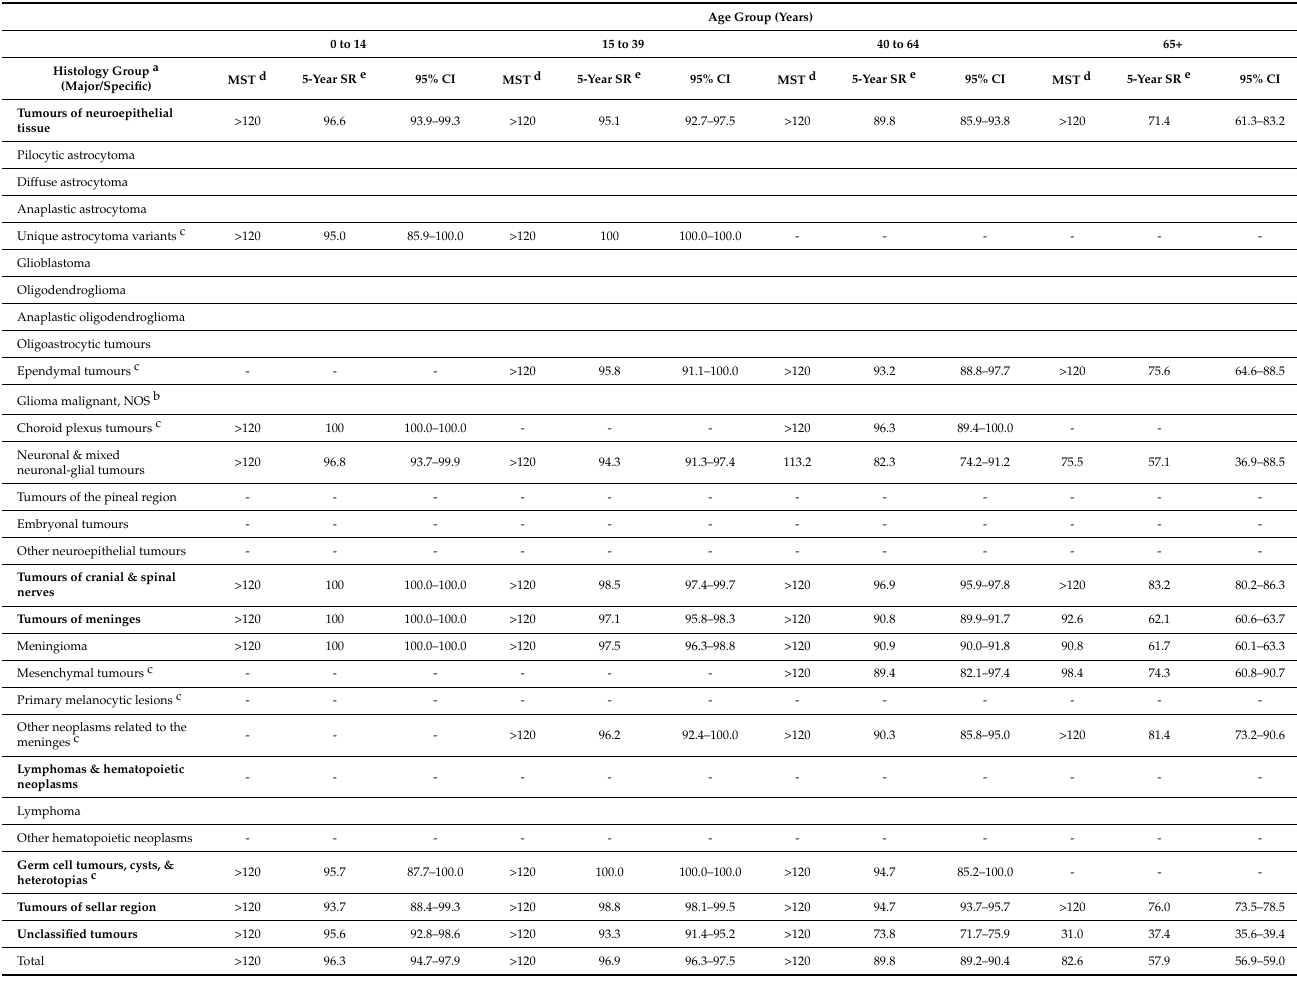
Table 4. Median survival times (MSTs), five-year survival rates (5-year SRs), and associated 95% confidence intervals (CIs) for patients with primary non-malignant CNS tumours diagnosed between 2010–2017 in Canada (excluding Quebec) by histology and age